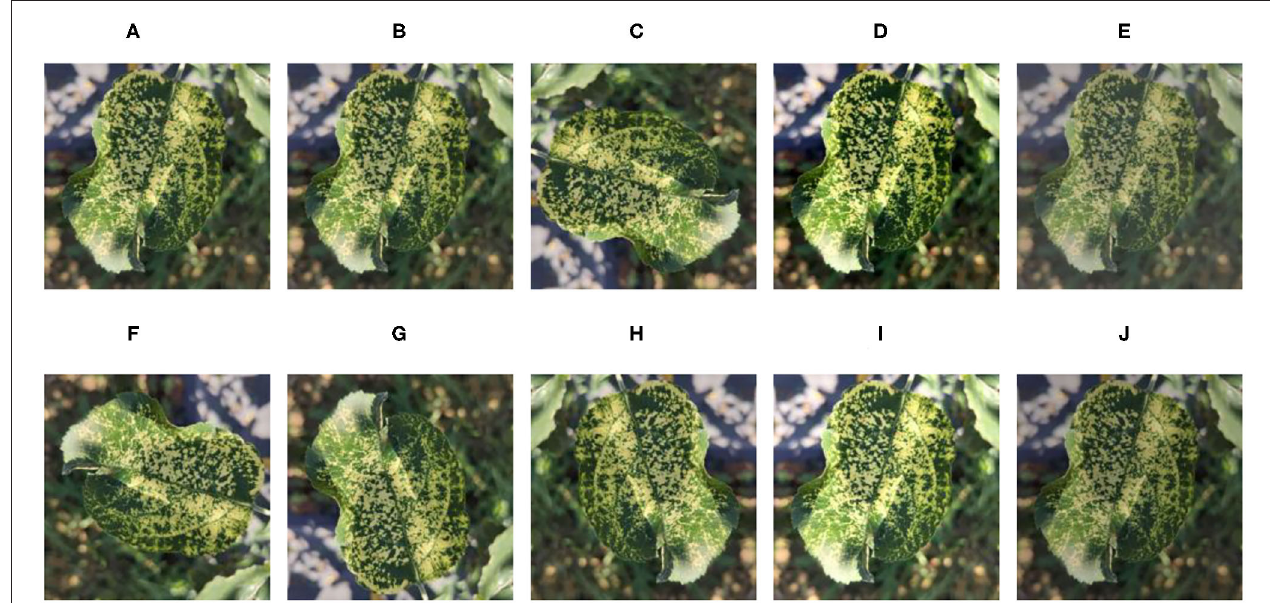
FIGURE 2 | Image enhancement example of the mosaic disease. (A) Original image, (B) Gaussian blur, (C) 90 ◦ rotation, (D) High contrast, (E) Low contrast, (F) 270 ◦ rotation, (G) Horizontal symmetry, (H) Vertical symmetry, (I) High brightness, and (J) Low